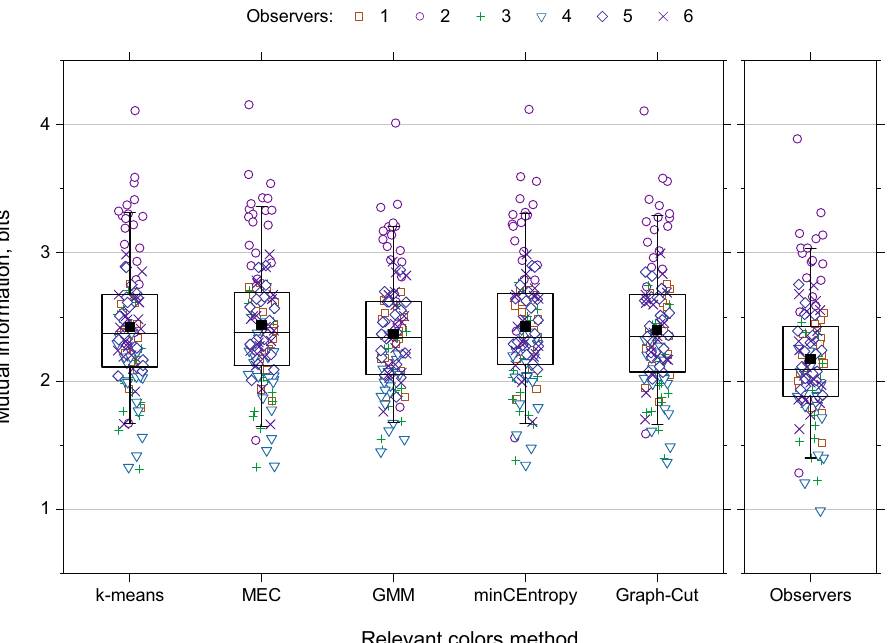
Figure 2. Information from relevant colors. Estimated mutual information between each of the 20 images in Fig. 1 and their quantized representations by relevant colors is shown for five clustering methods and six human observers, indicated by different symbols. Horizontal jitter has been added to reduce overlap between symbols 35 .